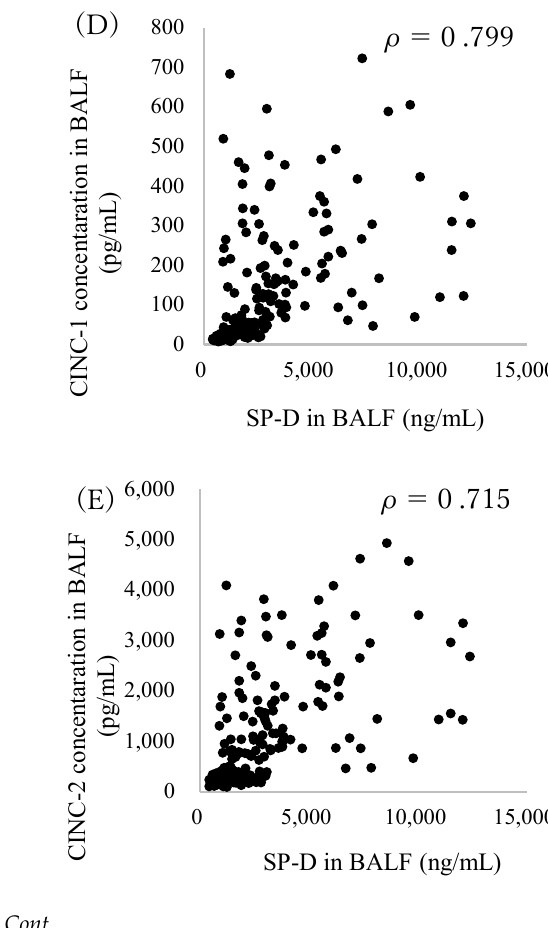
Figure 2. SP-D concentrations in BALF at each time point after intratracheal instillation of nanomaterials: ( A ) SP-D in low dose of intratracheal instillation, ( B ) SP-D in high dose of intratracheal instillation. Error bars represent mean ± SD for n = 5/group. Asterisks indicate significant differences compared with each control (Analysis of variance and Dunnett’s test) (* p < 0.05, ** p < 0.01). An average of negative controls in all experiments at each time point showed a single bar of negative control.